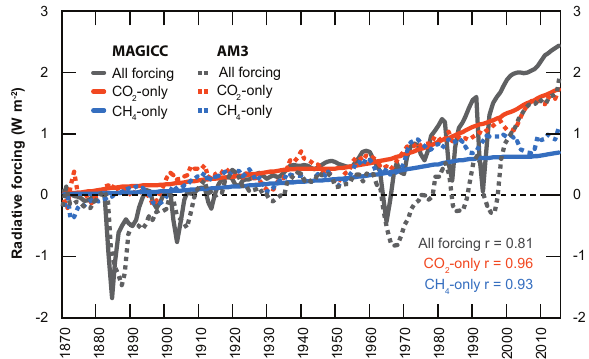
Figure 3. Radiative forcings (Wm − 2 ) after stratospheric adjust- ment due to all-forcing (grey), CO 2 -only (orange), methane-only (blue), and for both AM3 (dashed) and MAGICC (solid) model simulations. Methane forcing includes its direct as well as indirect effect from influences on chemistry. AM3 radiative forcings are “ef- fective” radiative forcings (ERFs), include tropospheric adjustments as well, and are calculated at the top of the atmosphere (TOA). MAGICC radiative forcings are calculated at the tropopause. AM3 data are 5-year running means. Correlation coefficients between MAGICC and AM3 forcings are shown